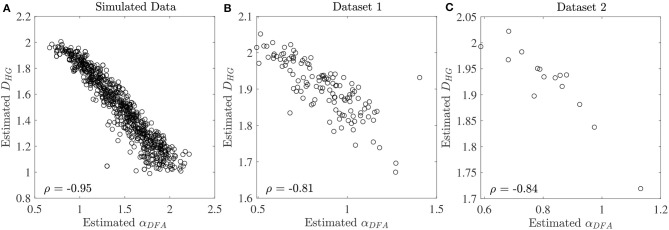
Correlation coefficients ρ between estimated αDFA and DHG at the series length of 128 data points for (A) the simulated fBm dataset, (B) the first experimental dataset, and (C) the second experimental dataset.